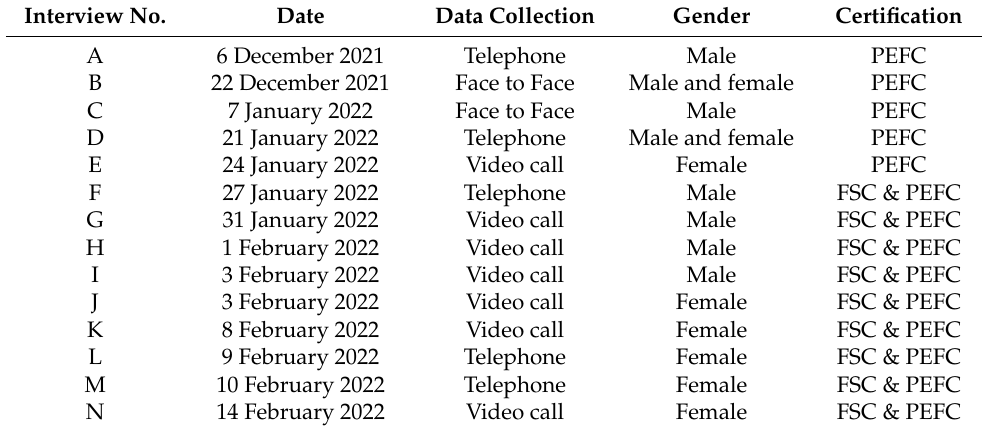
Table 1. Interviews carried out with certified forest